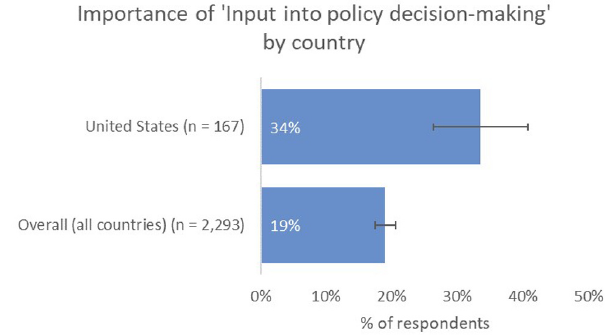
Figure 7. Relative importance of indexing in the JCR in determining choice of journal for US-based authors.